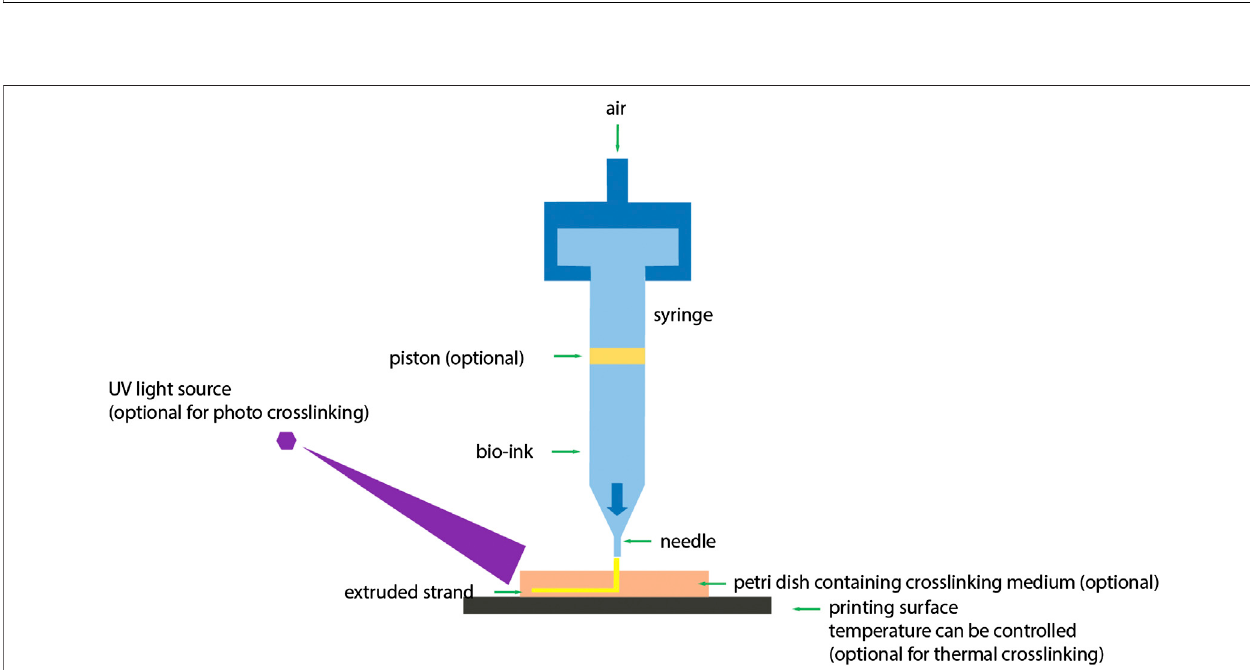
FIGURE3 | Schematic diagram ofextrusion based 3D bioprinting. In extrusion based 3Dbioprinting, applicationof pressure on bioinkis optional (You et al.,2017) (used from an open access journal).